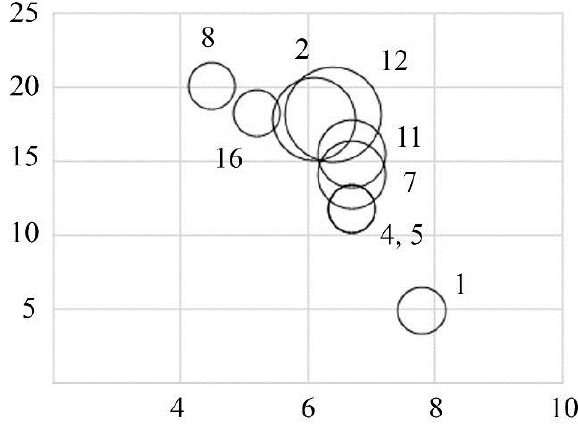
Figure 10. Dependence of species richness of centrohelids per biotope on the pH (X-axis) and temperature (Y-axis) of water. The diameter of the circle is directly proportional to the species richness of the biotope. The numbers of biotopes are given in accordance with Table